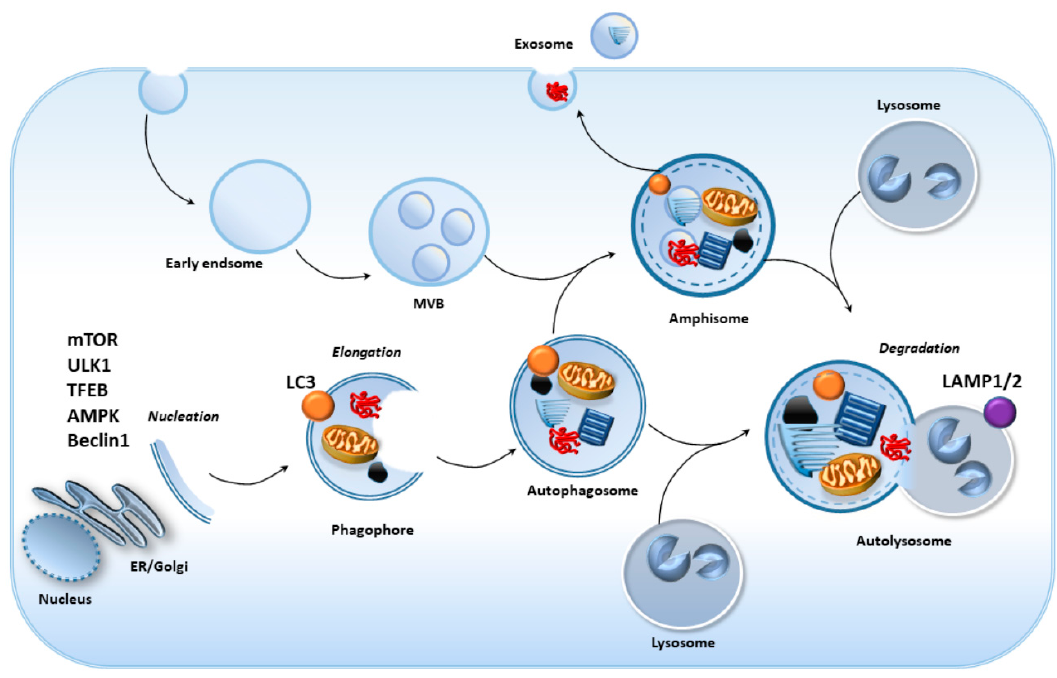
Figure 1. Schematic overview of the autophagy machinery progression. The recruitment of Atg proteins to the phagophore assembly site (nucleation) is followed by the formation of the phagophore, which engulfs various intracellular substrates. The phagosome gives birth to the autophagosome, which may either fuse with late endosomes (multivesicular bodies, MVB), leading to the formation of the amphisome, or fuse directly with lysosomes. The autolysosome, where cargo degradation eventually occurs, derives from the fusion of the amphisome or autophagosome with the lysosome. When amphisomes do not fuse with lysosomes, partially indigested cargos can be spread extracellularly via exosomes.